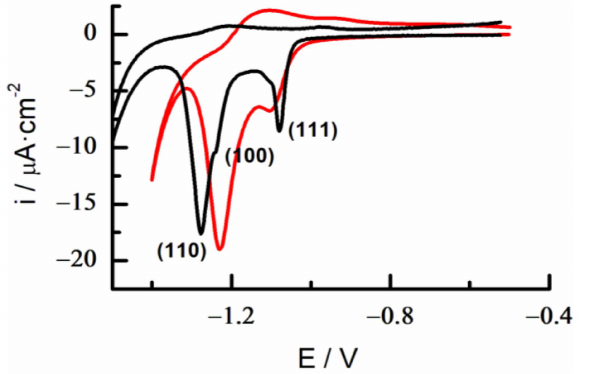
Figure 11. Cyclic voltammograms of the reductive desorption of MUA-SAMs on Au 18K (red) and polyfaceted gold (black) in KOH 0.1M. Scan rate 0.02